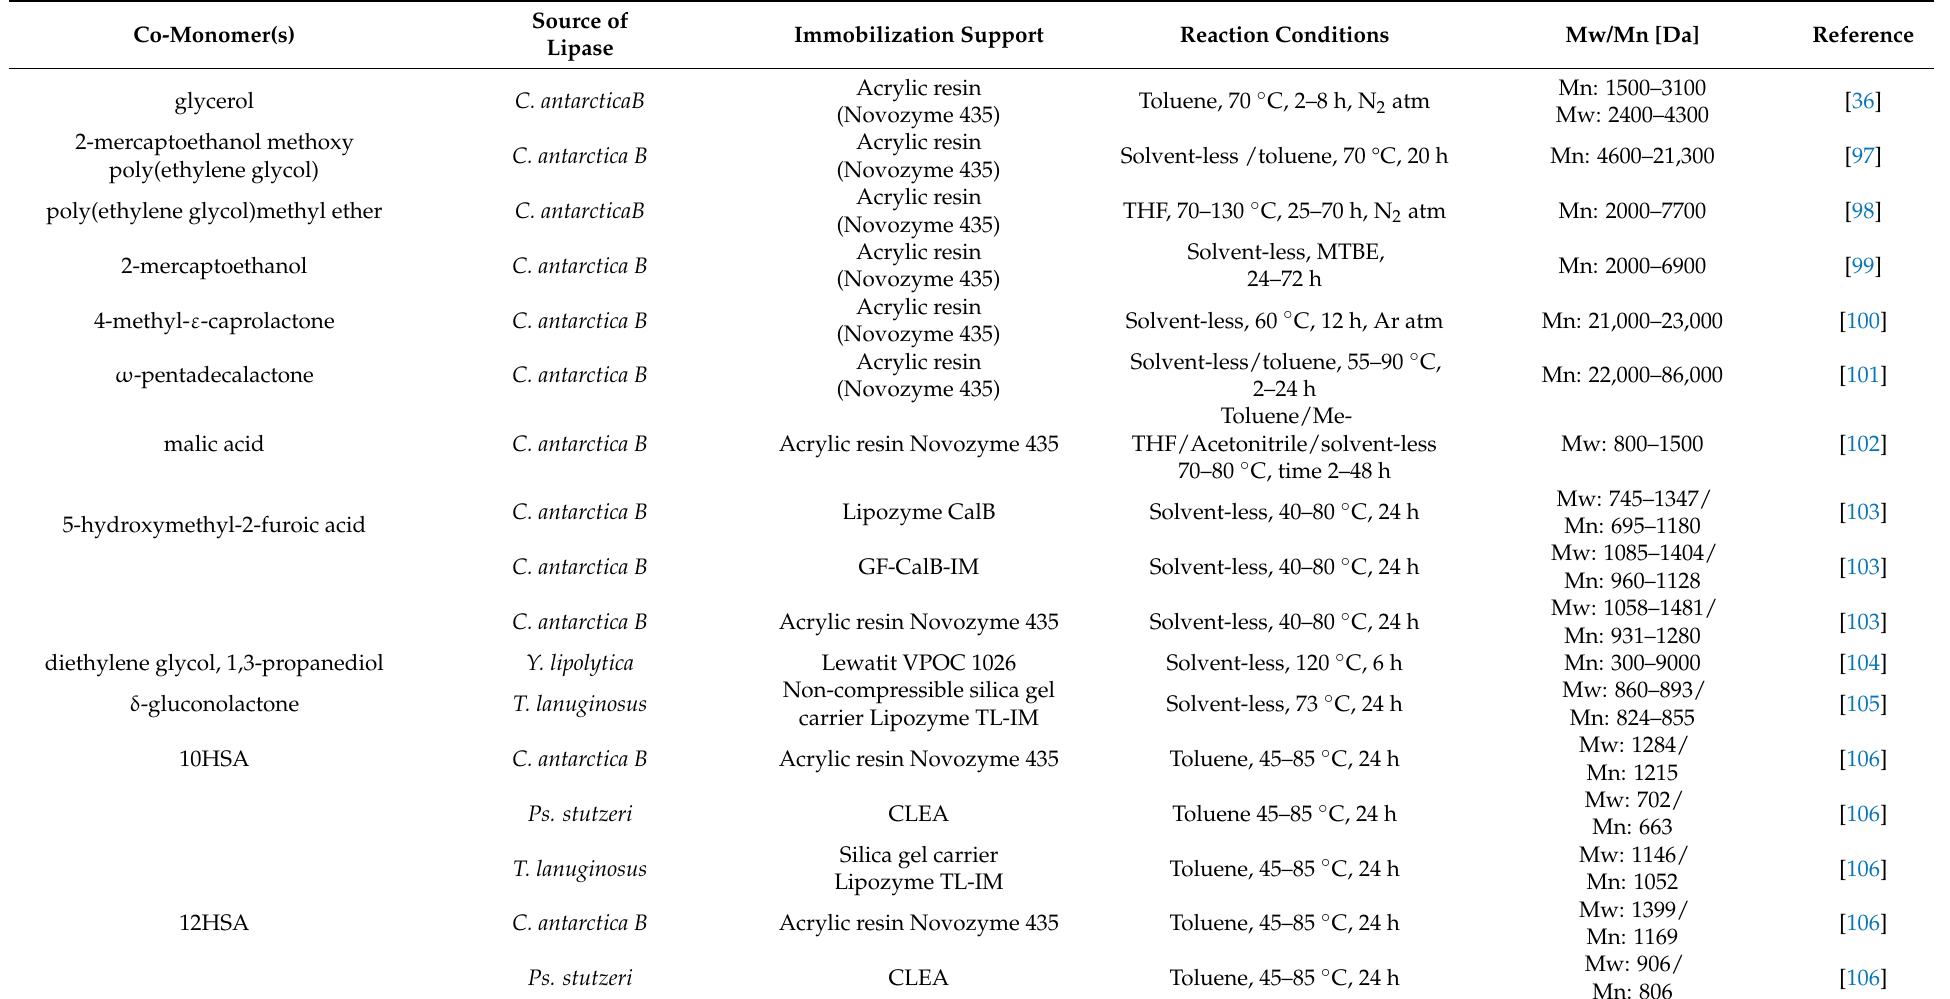
Table 2. Synthesis of ε -caprolactone co-polyesters catalyzed by native and immobilized